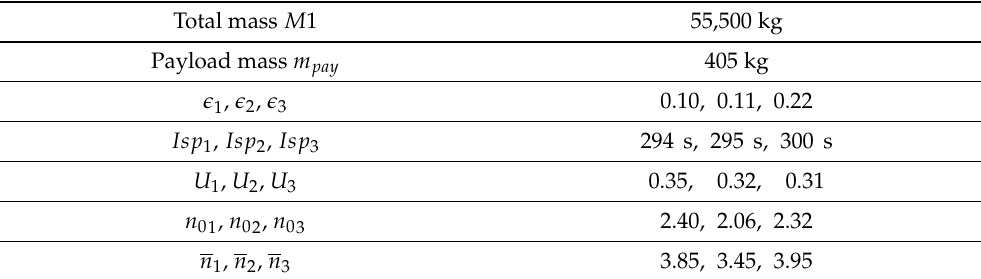
Table 3. Dataof the three-stage